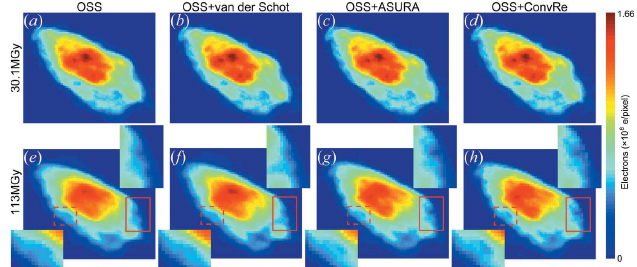
Figure 3 ( a )–( d ) Images reconstructed by different methods at a dose of 30.1 MGy. ( e )–( h ) Images reconstructed by different methods at a dose of 113 MGy. The images in the upper right corner are magnified views of the regions indicated by red solid rectangles, and the images in the lower left corner are magnified views of the regions indicated by the red dashed